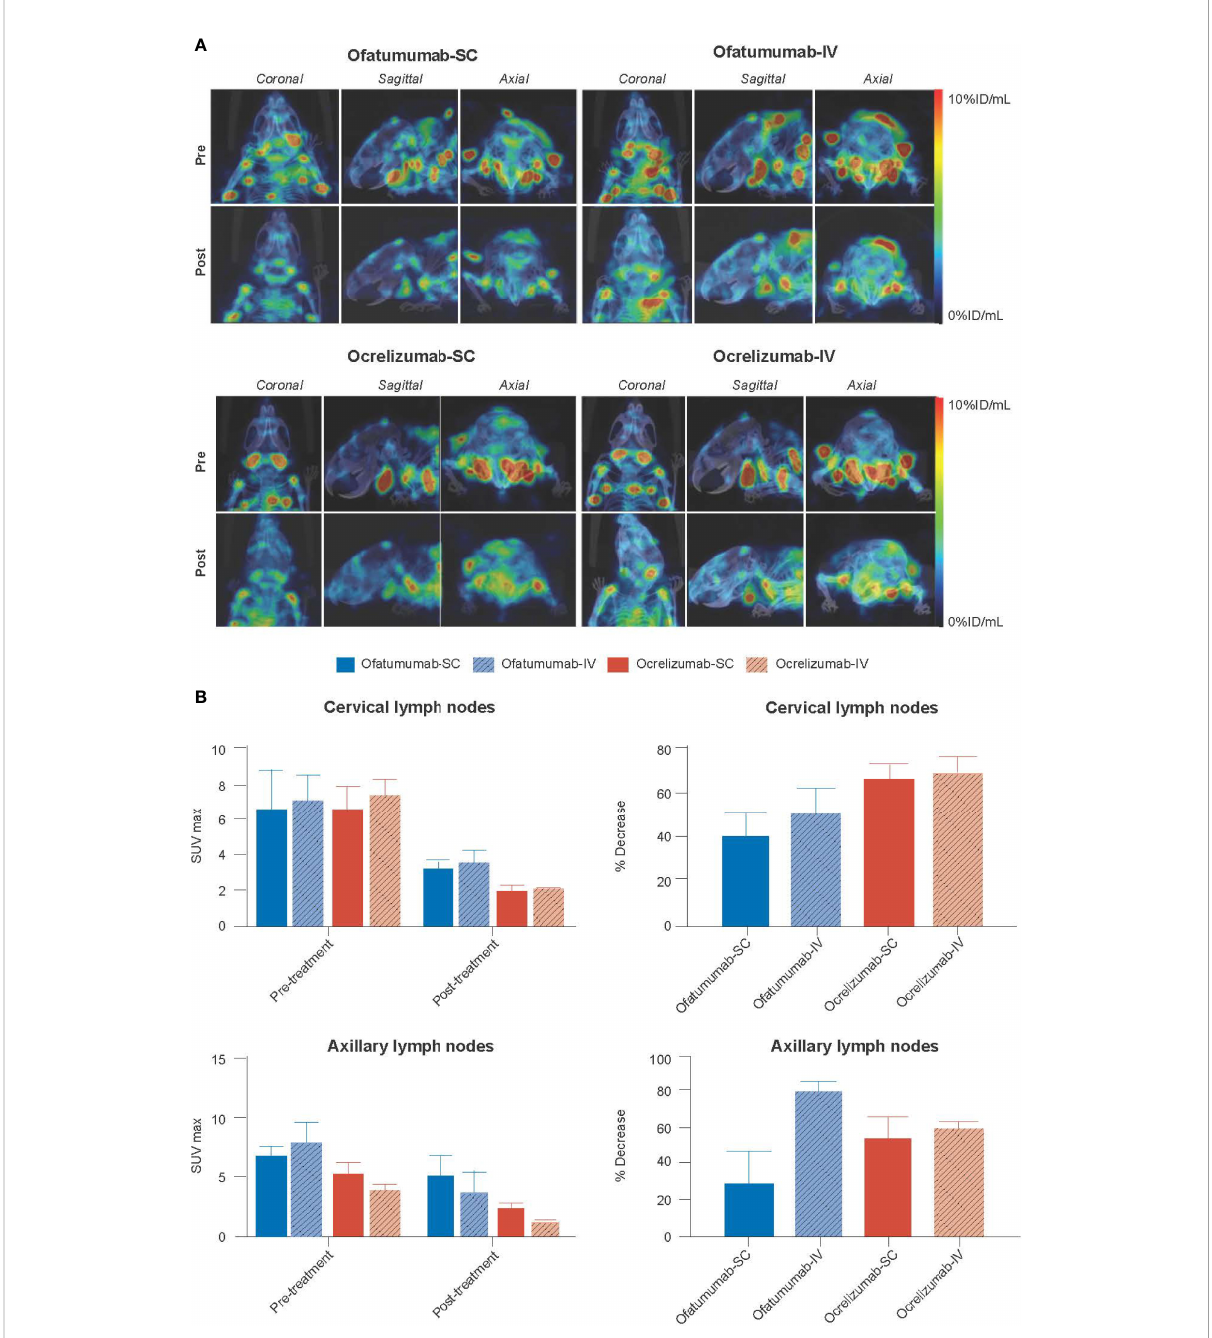
FIGURE 4 (A) Representative MIP SPECT/CT images of huCD20 mice 72 h after SC administration of 111 In-anti-CD19 (pre) and 72 h after SC administration of 111 In-anti-CD19 following 18 days of treatment with SC or IV ofatumumab or ocrelizumab (post). A reduction in 111 In-anti-CD19 signal in lymph nodes, representing B-cell depletion, is noted post treatment. (B) Two-way ANOVA revealed that all treatments signi fi cantly reduced the 111 In-anti-CD19 signal over time in the cervical lymph nodes and axillary lymph nodes, but no signi fi cant difference in SUVmax was observed between groups (route of administration or antibody). There was also no signi fi cant difference in the relative decrease in SUVmax between groups, as assessed by one-way ANOVA. Data represent mean ±